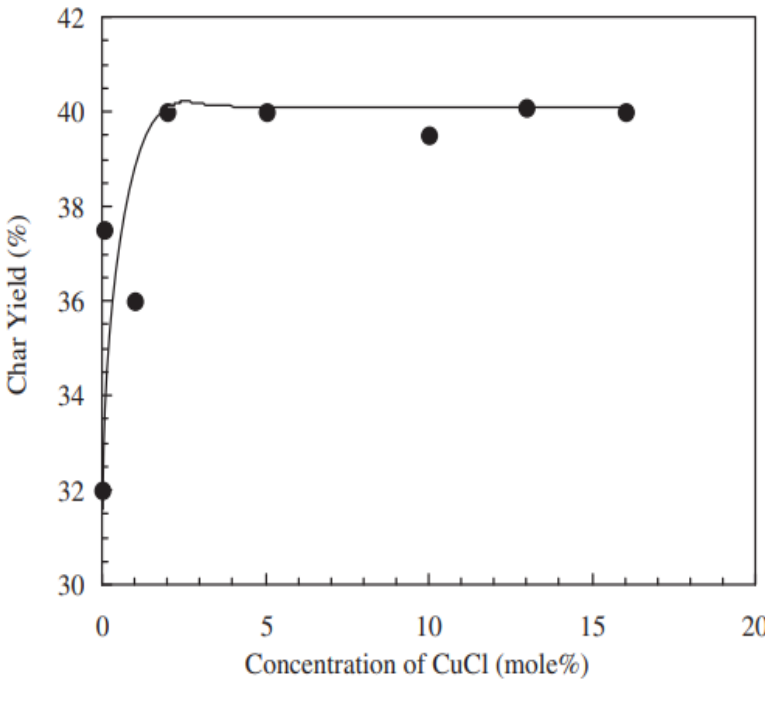
Figure 8. Effect of CuCl initiator concentration on char yield for 3-aminphenylacetylene based benzoxazines (Reproduced from [47] with permission).